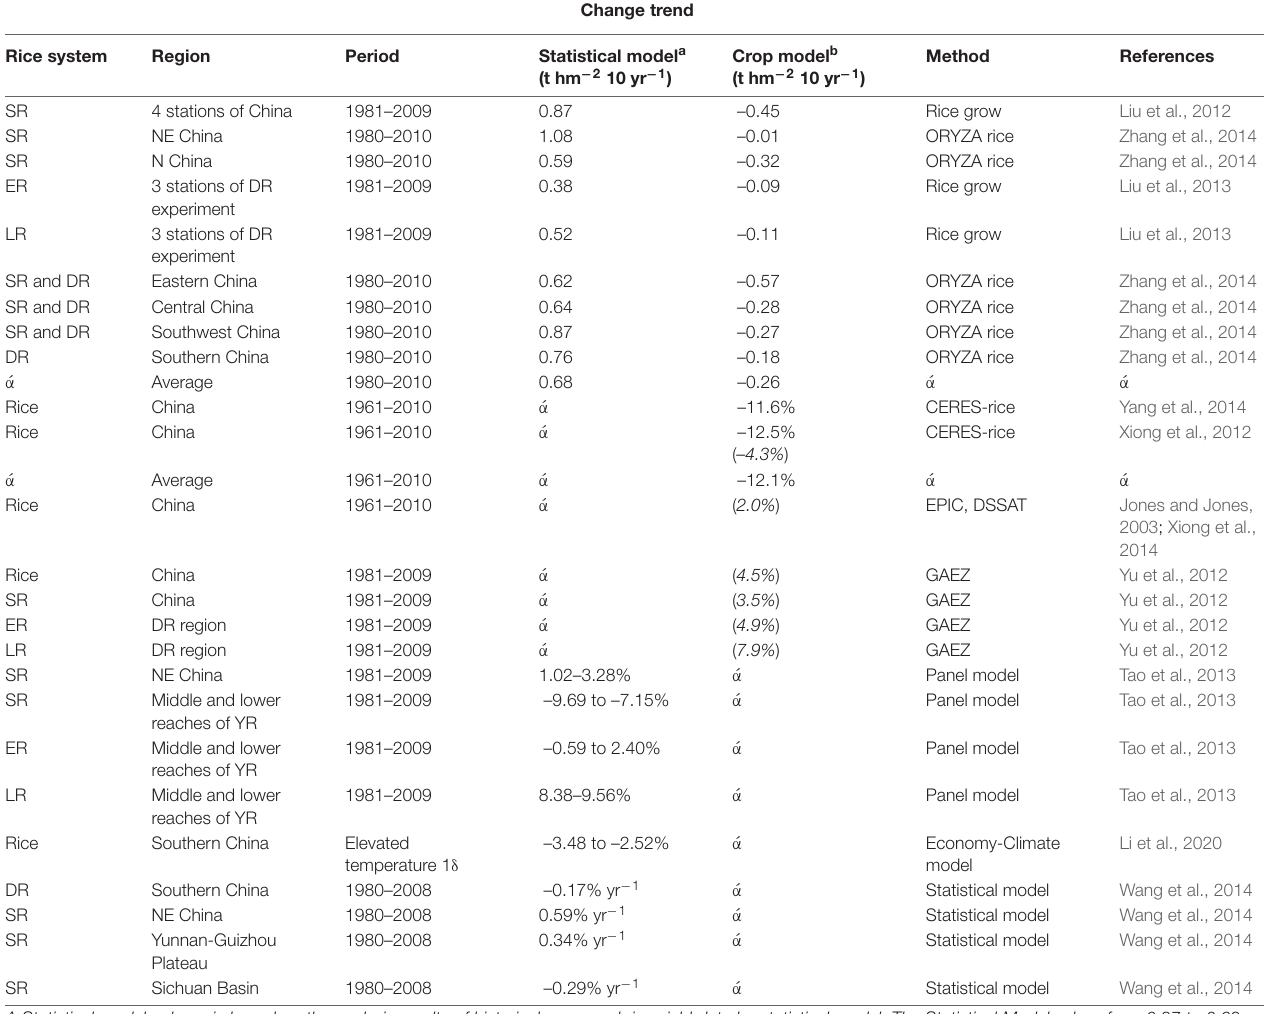
TABLE 1 | Impact of climate change on rice grain yield in China.